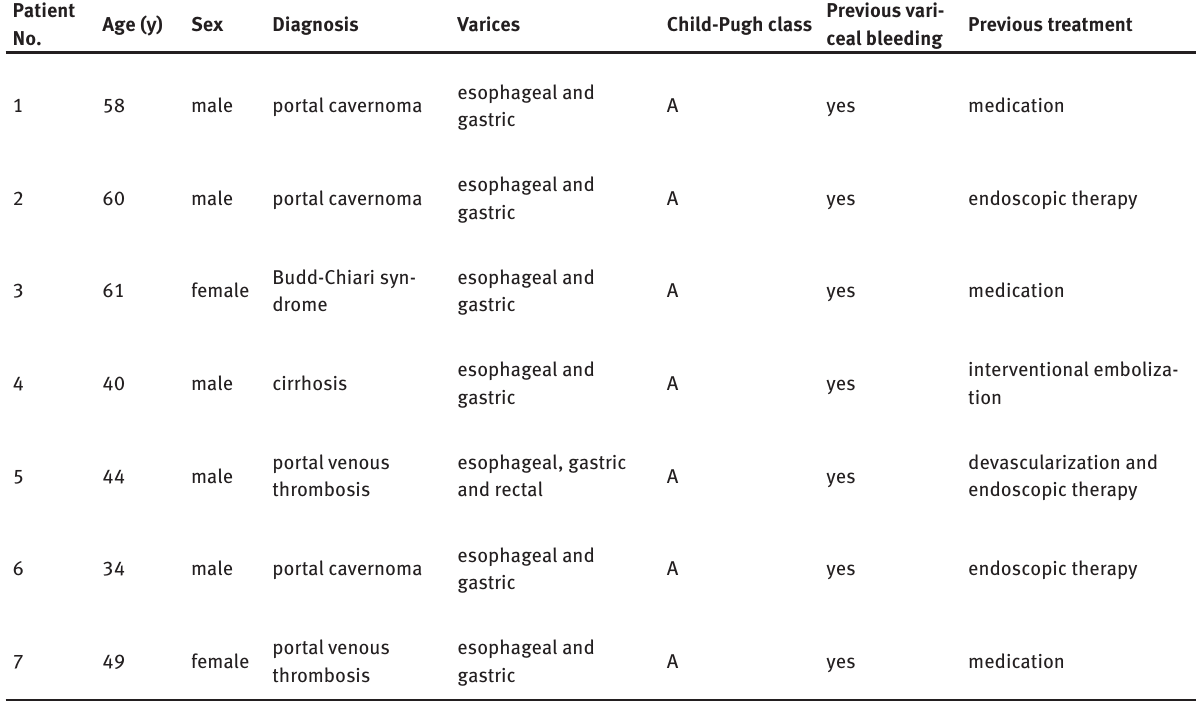
Table 1: Clinical characteristics of patients